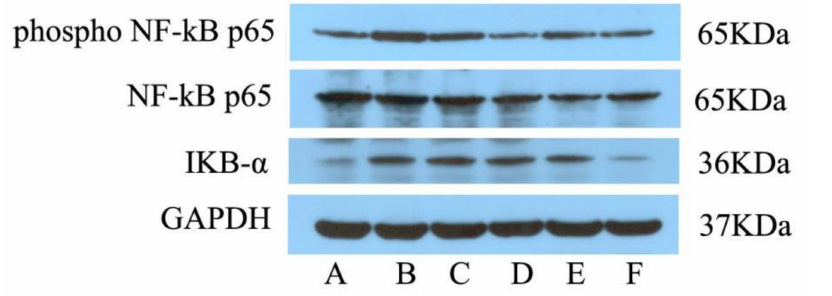
Figure 4. Effects of ellagic acid on P-NF- κ B p65 and IKB- α protein expression in hypothalamus tissue of pyretic rats induced by brewer’s yeast as measured by Western blot. A~F:NG, MG, APG, EALG, EAMG, EAHG.